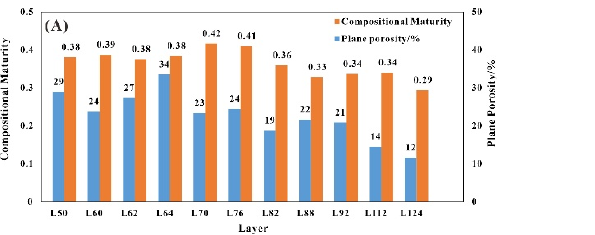
Figure 17. ( A ) Compositional maturity and plane porosity distribution. ( B ) Correlation between compositional maturity and plane porosity.